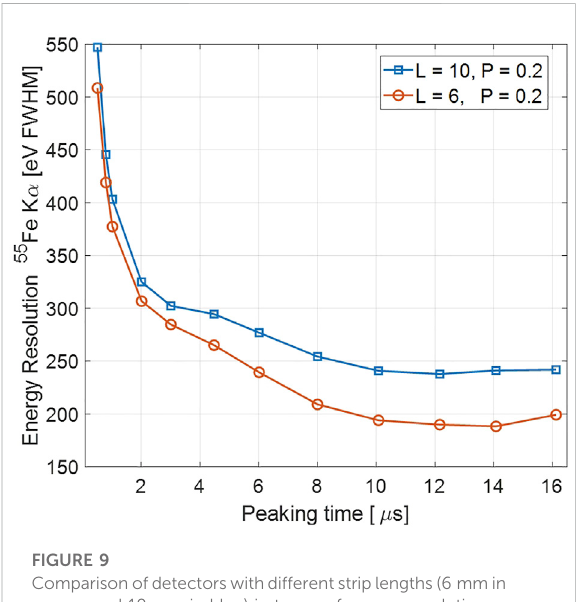
FIGURE 9 Comparison ofdetectorswithdifferentstriplengths(6 mmin orange and 10 mm in blue) in terms of energy resolution vs. peaking time. The lower noise of the shorter strip is evident.